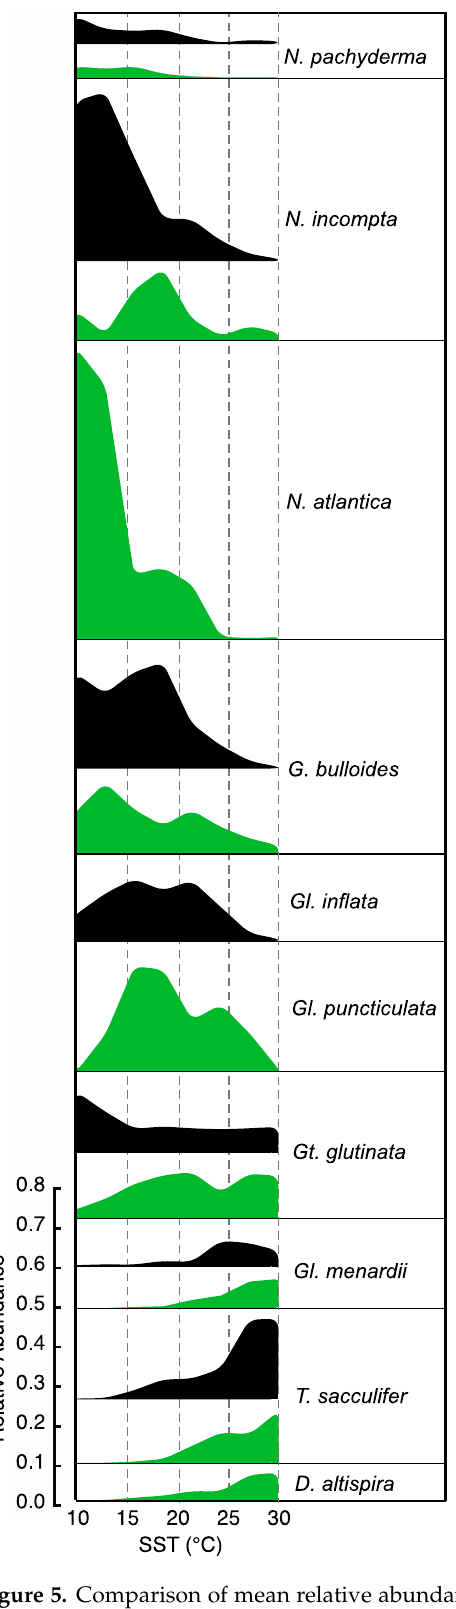
Figure 5. Comparison of mean relative abundances within 2.5 ◦ C temperature bins ranging from 10 ◦ C to 30 ◦ C for seven extant species ( N. pachyderma , N. incompta , G. bulloides , Gl. inflata , Gt. glutinata , Gl. menardii , T. sacculifer ) and three extinct species ( N. atlantica , Gl. puncticulata , D. altispira ). Pliocene data are shown in green, core-top data in